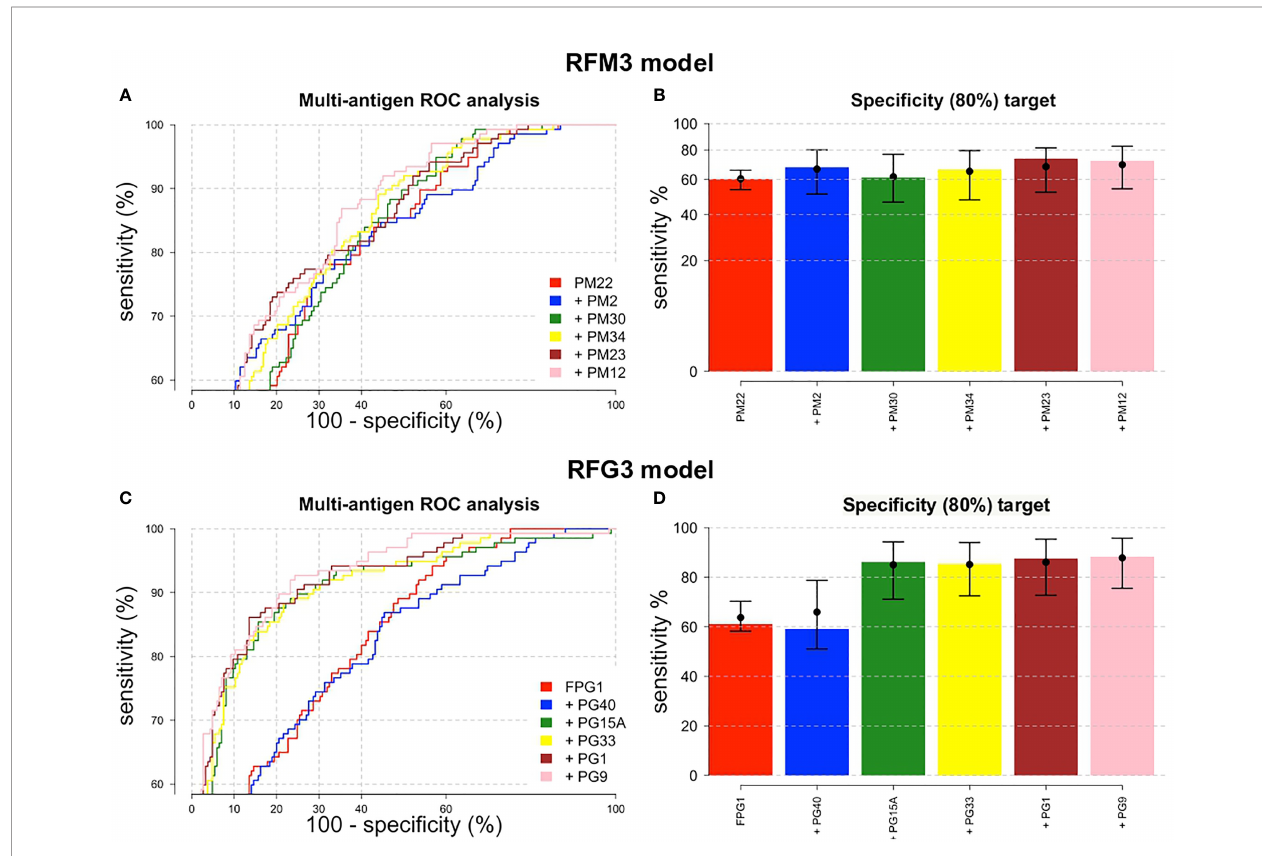
FIGURE 5 | ROC performance analysis combining multiple peptides using a random forest algorithm. ROC curves for (A) IgM and (C) IgG peptides. The peptides are added sequentially based on their classi fi cation accuracy. The axes have been rescaled to better differentiate between high values of sensitivity and speci fi city. (B) For a pre-de fi ned assay speci fi city of 80%, the assay sensitivity increases with sequentially adding additional peptide biomarkers for detecting IgM (B) and IgG (D) . Sensitivity was estimated using a random forest classi fi er. Points and whiskers denote the median and 95% CIs from repeat